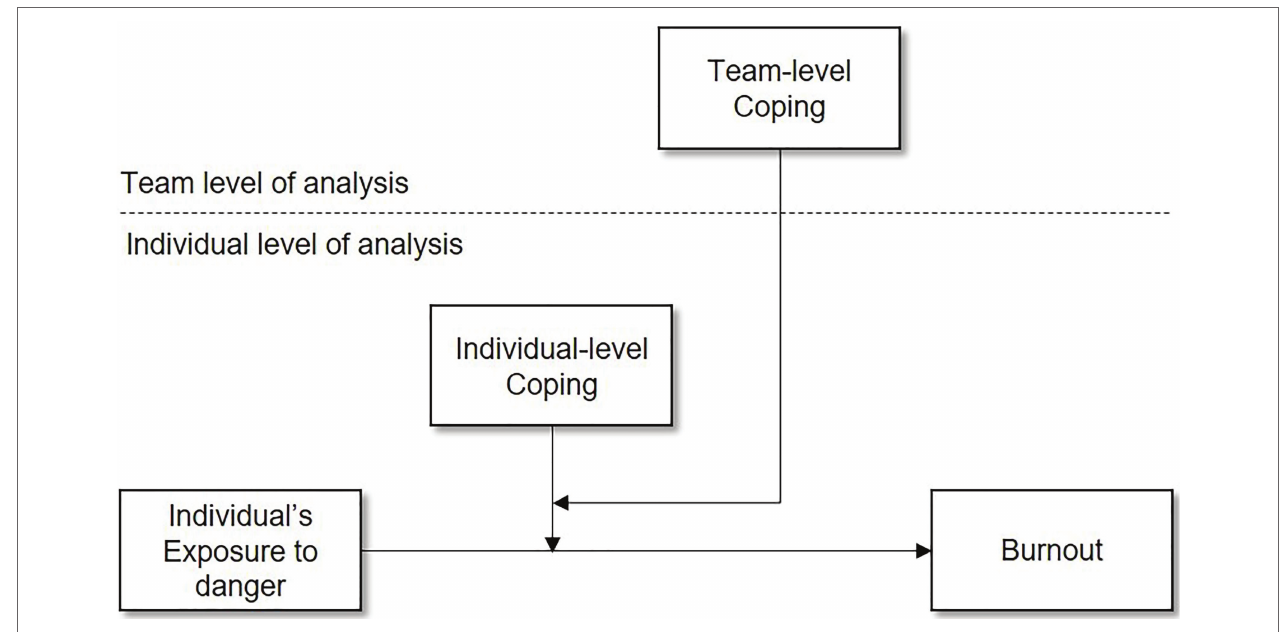
FIGURE 1 | Conceptual multilevel model of